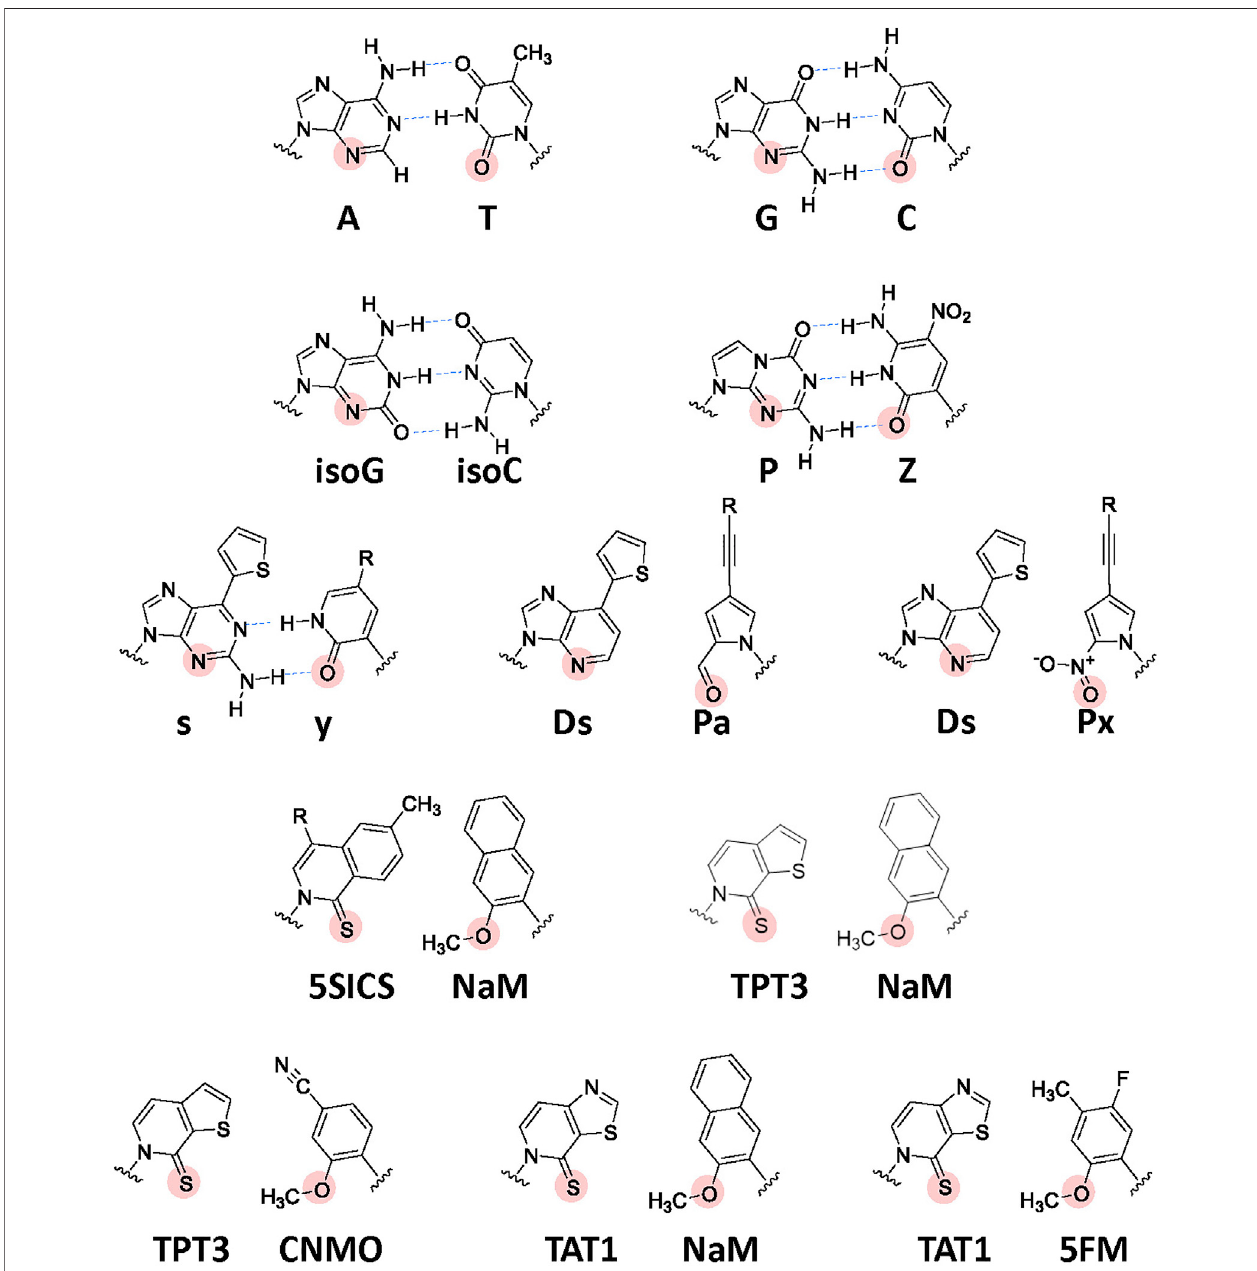
FIGURE 4 | Chemical structures of the natural Watson – Crick base pairs and a variety of UBPs developed to expand the genetic alphabet. Hydrogen-bonding interactions between the cognate base pairs are shown by blue arrows. The important residues (hydrogen acceptors) recognized by DNA and RNA polymerases are indicated by solid circles. R: further modi fi cation is available by attaching a variety of functional groups via linkers.